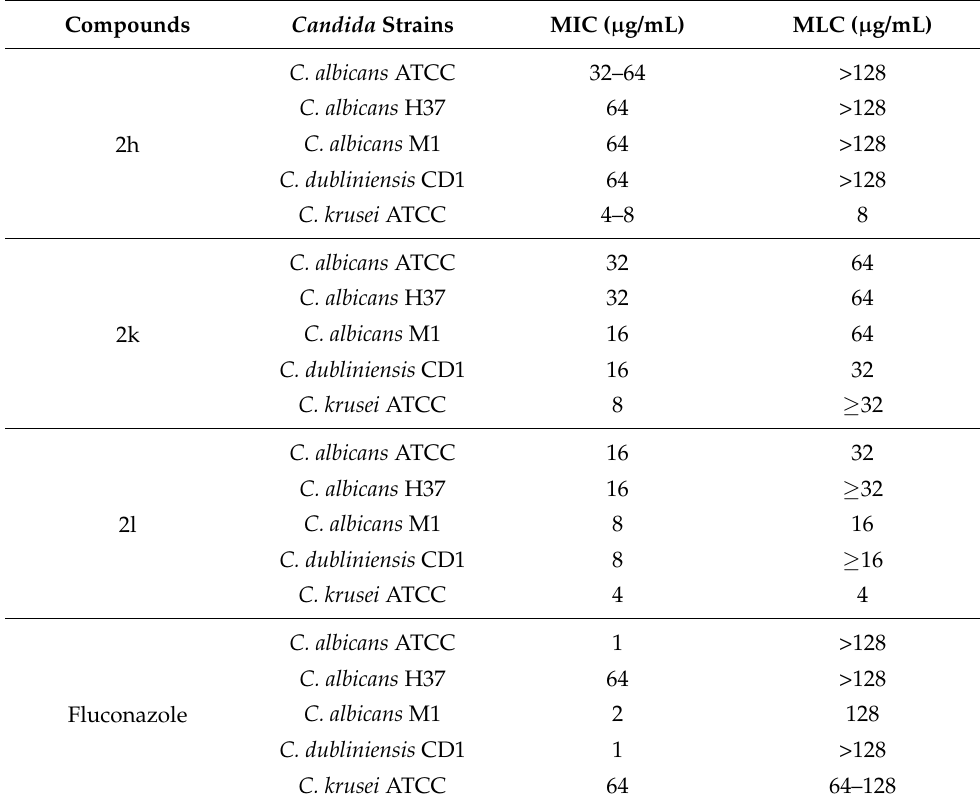
Table 1. Antifungal activity (minimal inhibitory concentration (MIC) and minimal lethal concentra- tion (MLC)) of 5-aminoimidazole-4-carbohydrazonamide derivatives against Candida